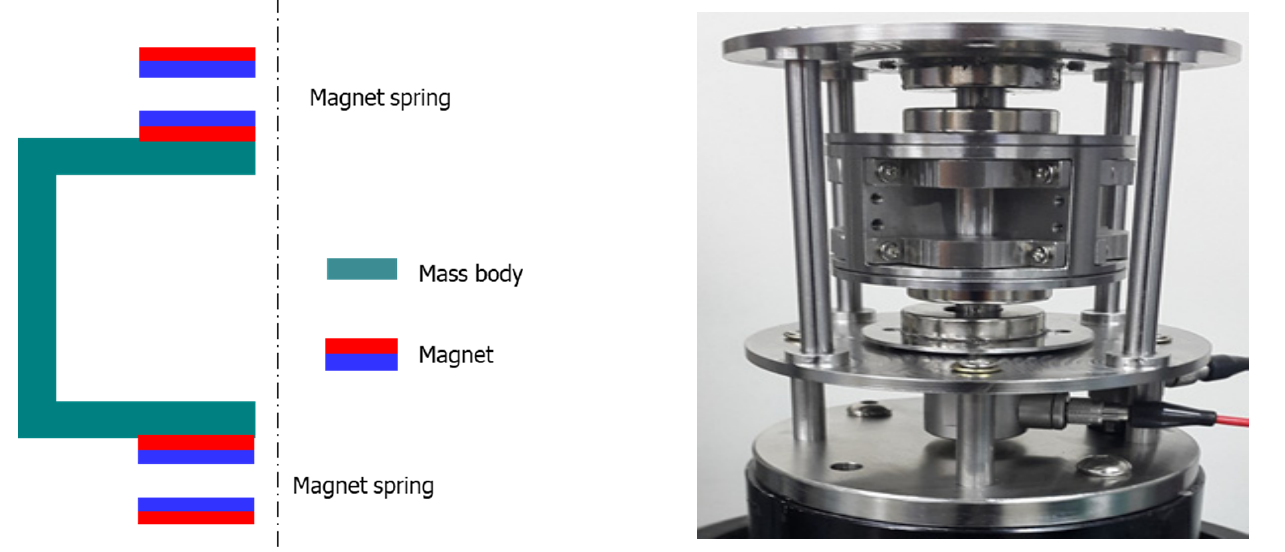
Figure 4. Schematic of the magnetic spring ( left ) and the magnetic repulsive force tester with the load cell ( right ).